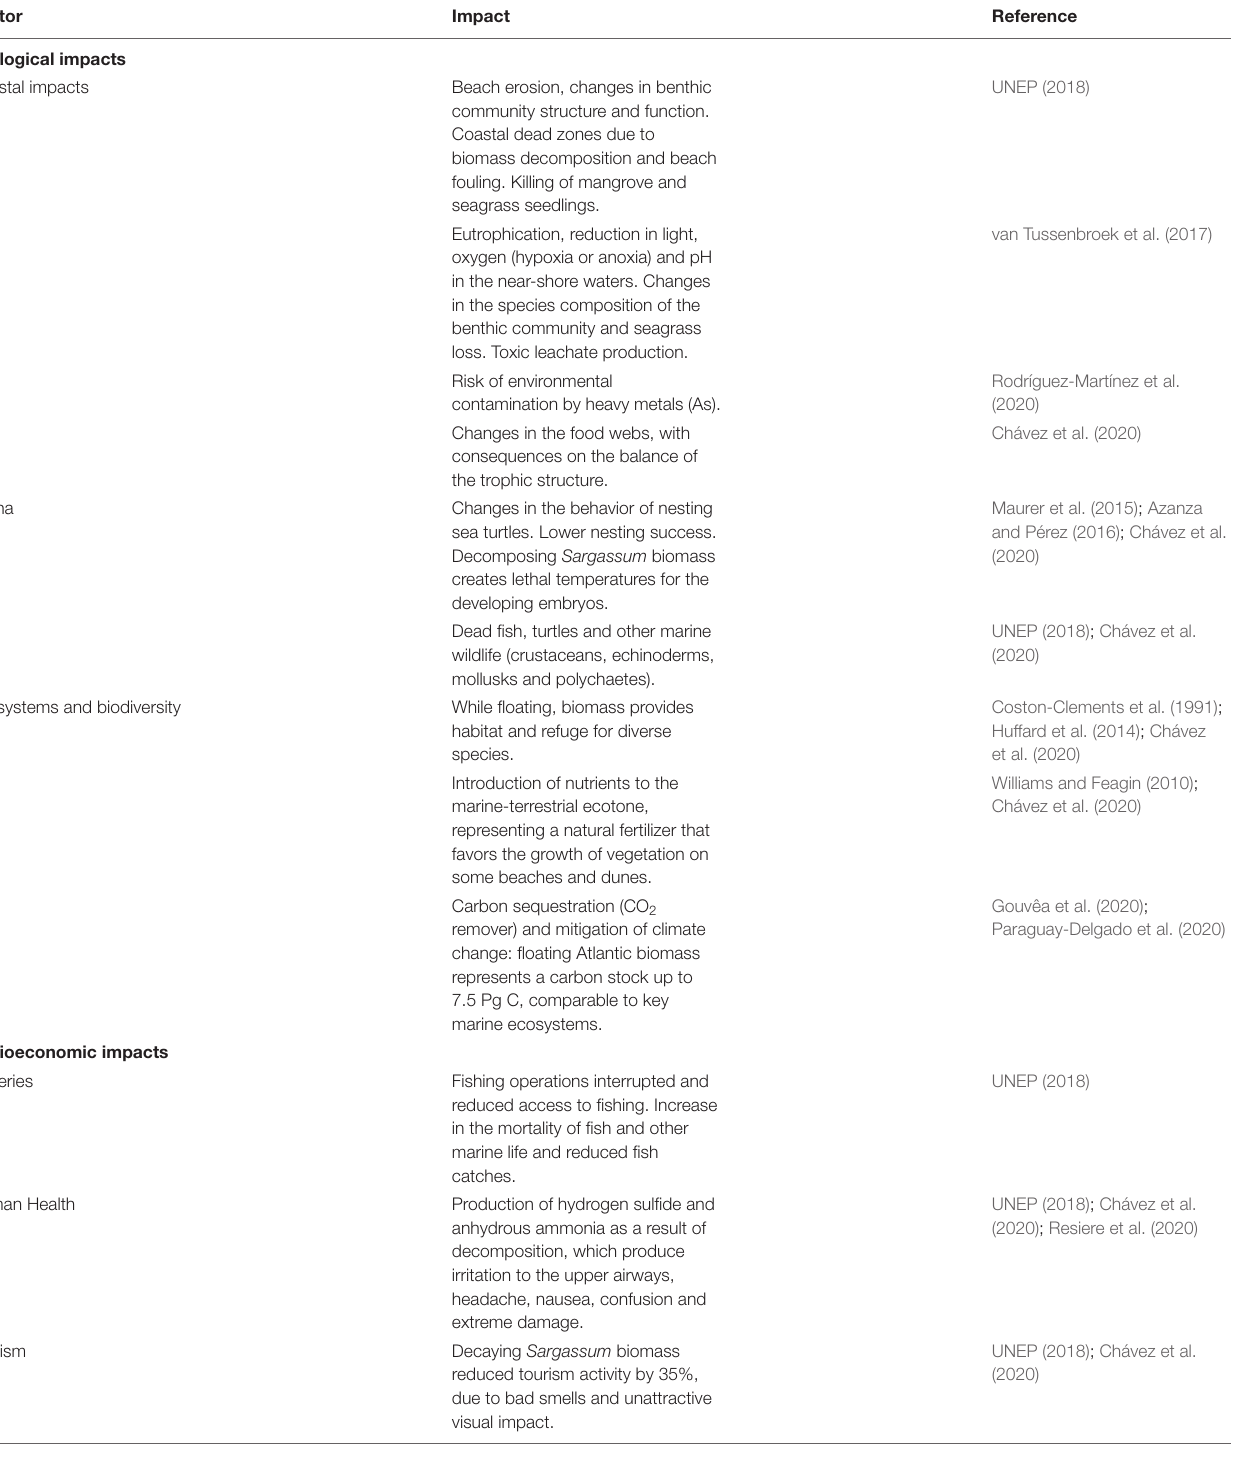
TABLE 2 | Ecological and socioeconomic impacts of Sargassum events for the Atlantic coasts, with special attention to the Caribbean region/Western Atlantic.